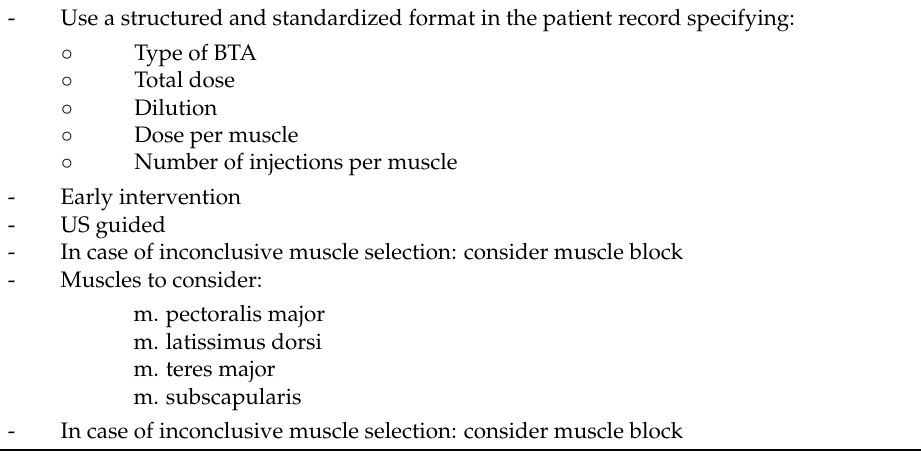
Table 2. Advised approach of BTA intervention in spastic